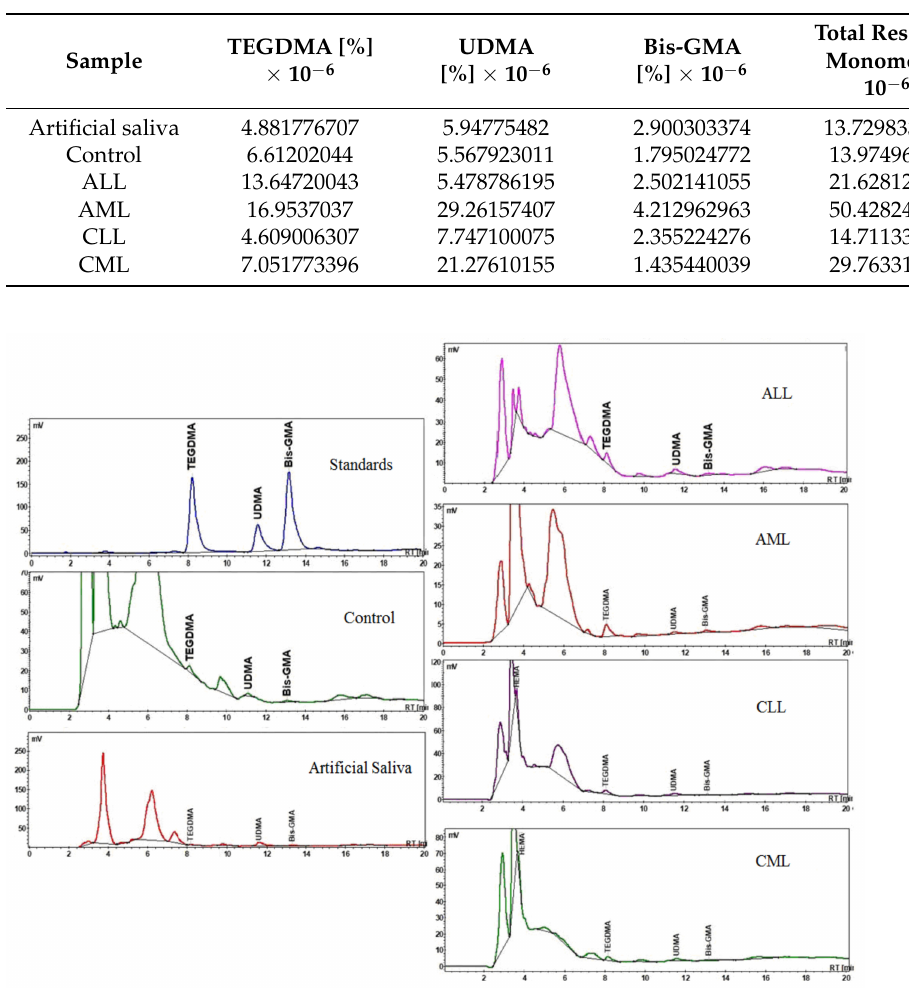
Figure 3. HPLC chromatograms of residual monomers from different saliva